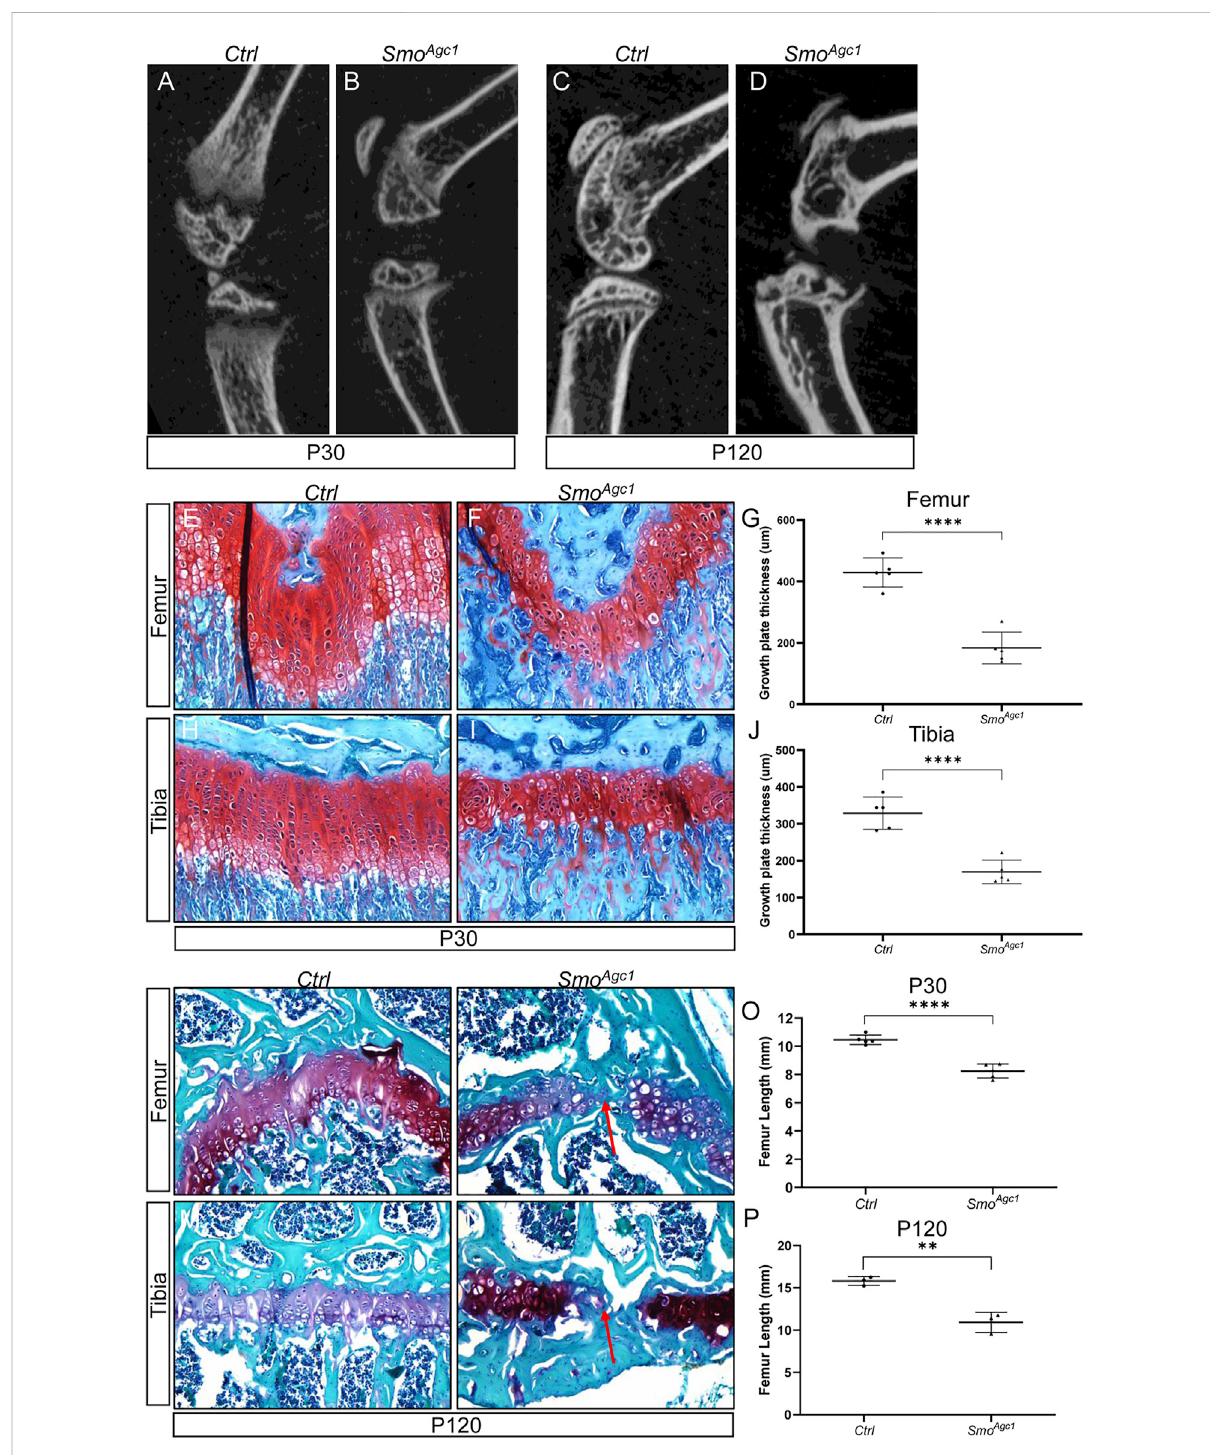
FIGURE 2 Chondrocyte-speci fi cdeletionof Smo injuvenilemiceledtodefectsinepiphysealgrowthplateandlimbelongation (A – D) RepresentativeuCT slicesofthekneejointregionin Agc1-CreER T2 ;Smo f/f ( Smo Agc1 ) (A,C) andcontrolmice(Ctrl) (B,D) treatedwithtamoxifenatP14-P18andharvestedat P30 (A,B) or P120 (C,D) (E,F) Safranin O staining of distal femoral growth plates from P30 Ctrl and Smo Agc1 mice (G) Quanti fi cation of average thickness of distal femoral growth plates (H,I) Safranin O staining of proximal tibial growth plates from P30 Ctrl and Smo Agc1 mice (J) . Quanti fi cationofaveragethicknessofproximaltibialgrowth plates( K – N) SafraninOstainingofgrowth platesindistalfemurs (K,L) orproximaltibiae (M,N) from P120 Ctrl and Smo Agc1 mice. Red arrows indicated the fusion of the growth plates in the mutant distal femurs and proximal tibiae (O,P) . Measurement of average lengths of femurs from Ctrl and Smo Agc1 mice at P30 (O) and P120 (P) . All quantitative data were shown as individual data points from each mouse together with mean ± standard deviation. p values were obtained by Student ’ s t-test and degrees of statistical signi fi cance were designated by different numbers of asterisk (*) in the fi gures: *, p < 0.05 ; **, p < 0.01 ; ***, p < 0.001 ; ****, p < 0.0001